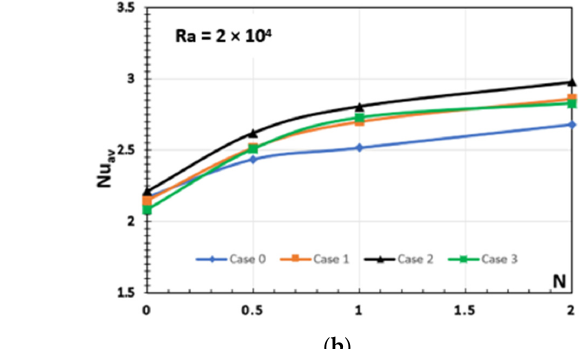
× 10 4 ( b ) on the average heat